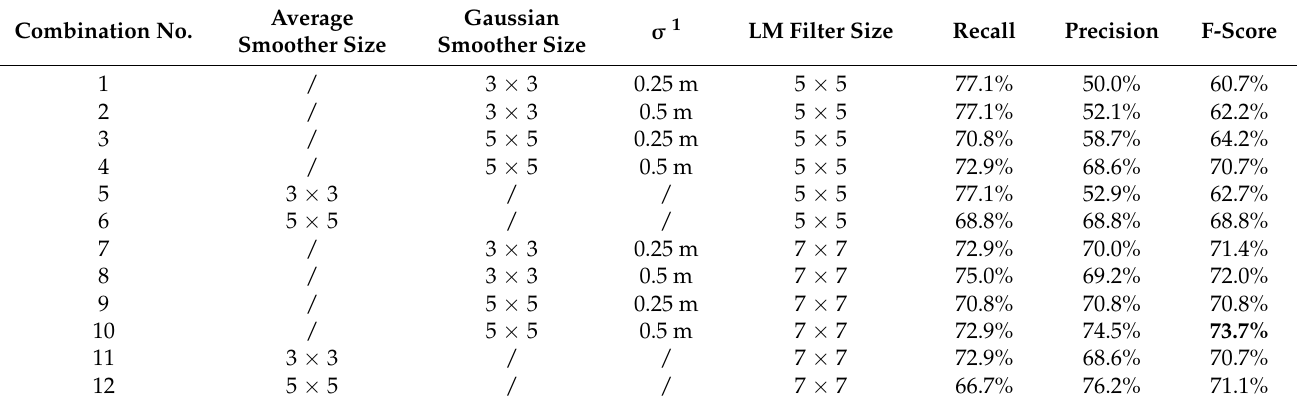
Table 2. List of LM extraction-related parameter values and corresponding tree detection results for comparison on test site 1. The values of the parameters related to filtering of initially extracted LMs were fixed. MaxD = 1.5 m, significance level = 0.10, and score threshold = 9.